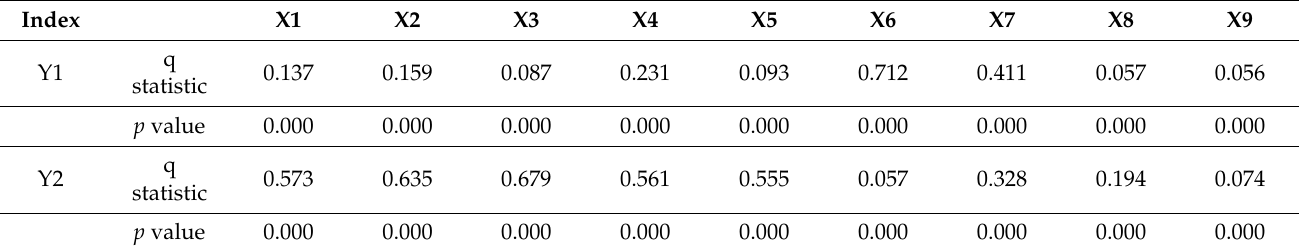
Table 14. Driving force spatial